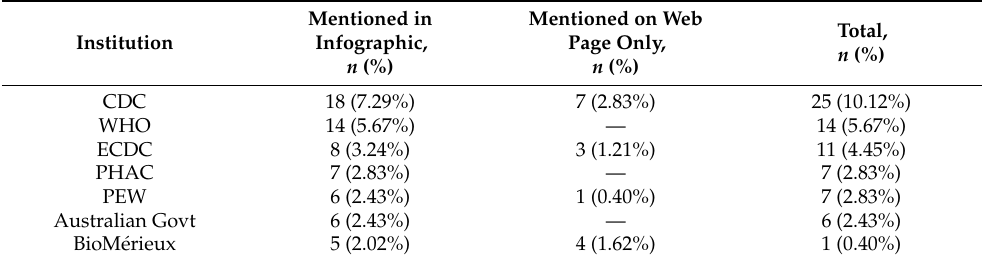
Table 2. Institutions endorsing 5 or more infographics on antibiotics and visibility of the